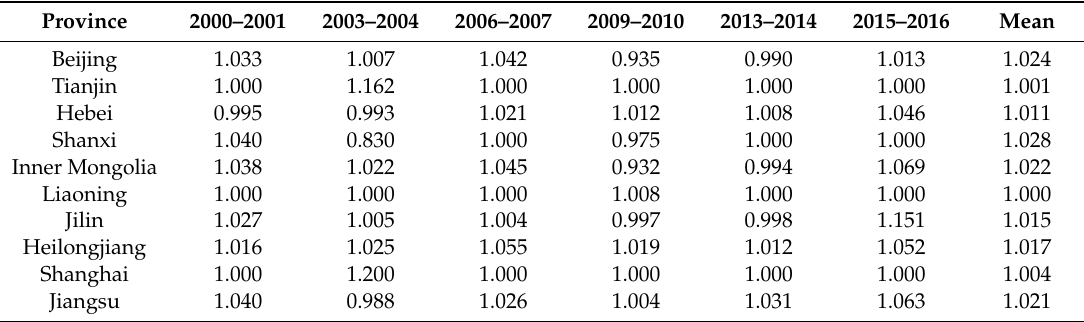
Table 2. Water resources green e ffi ciency for selected periods based on Hybrid Directional Distance Function-Global Malmquist-Luenberger (HDDF-GML)